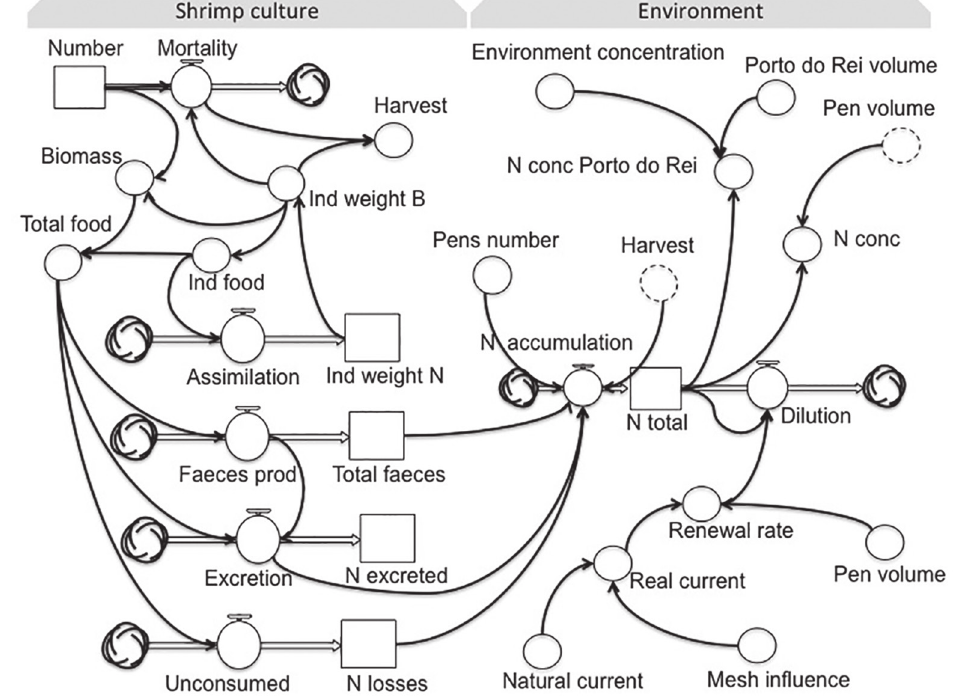
Figure 3 - Model used to estimate the maximal number of pen enclosures that could be installed at the Porto do Rei bay, Patos Lagoon estuary,